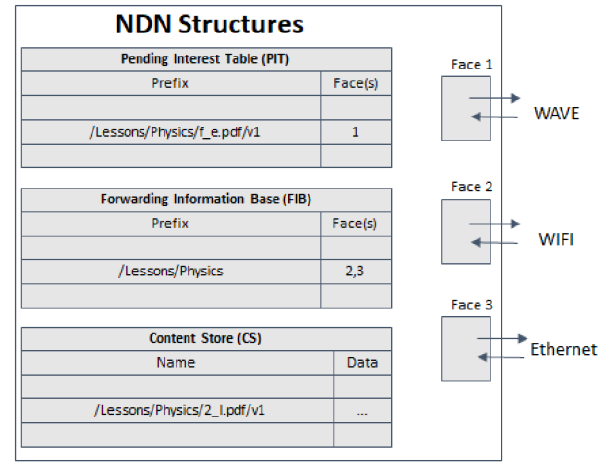
Figure 2. NDN data structures.